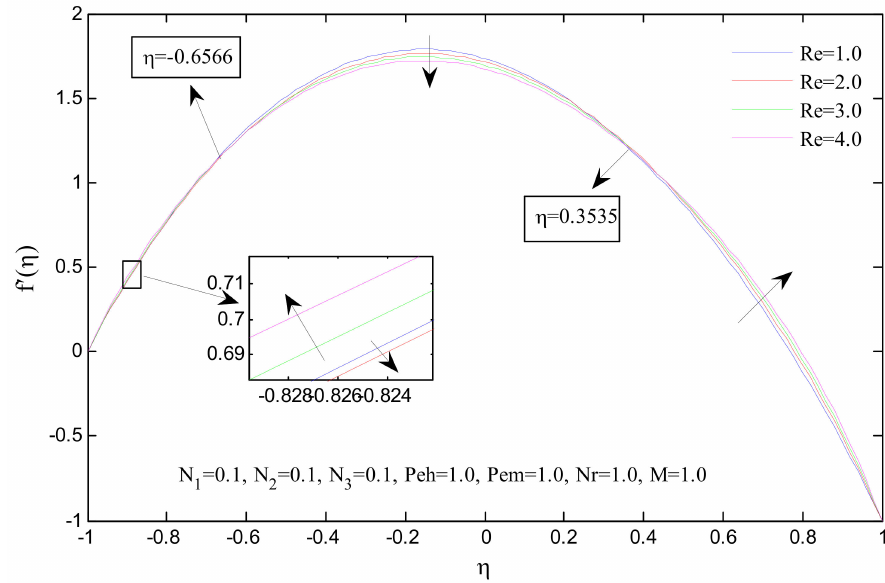
Figure 5. Effect of Re on simulated